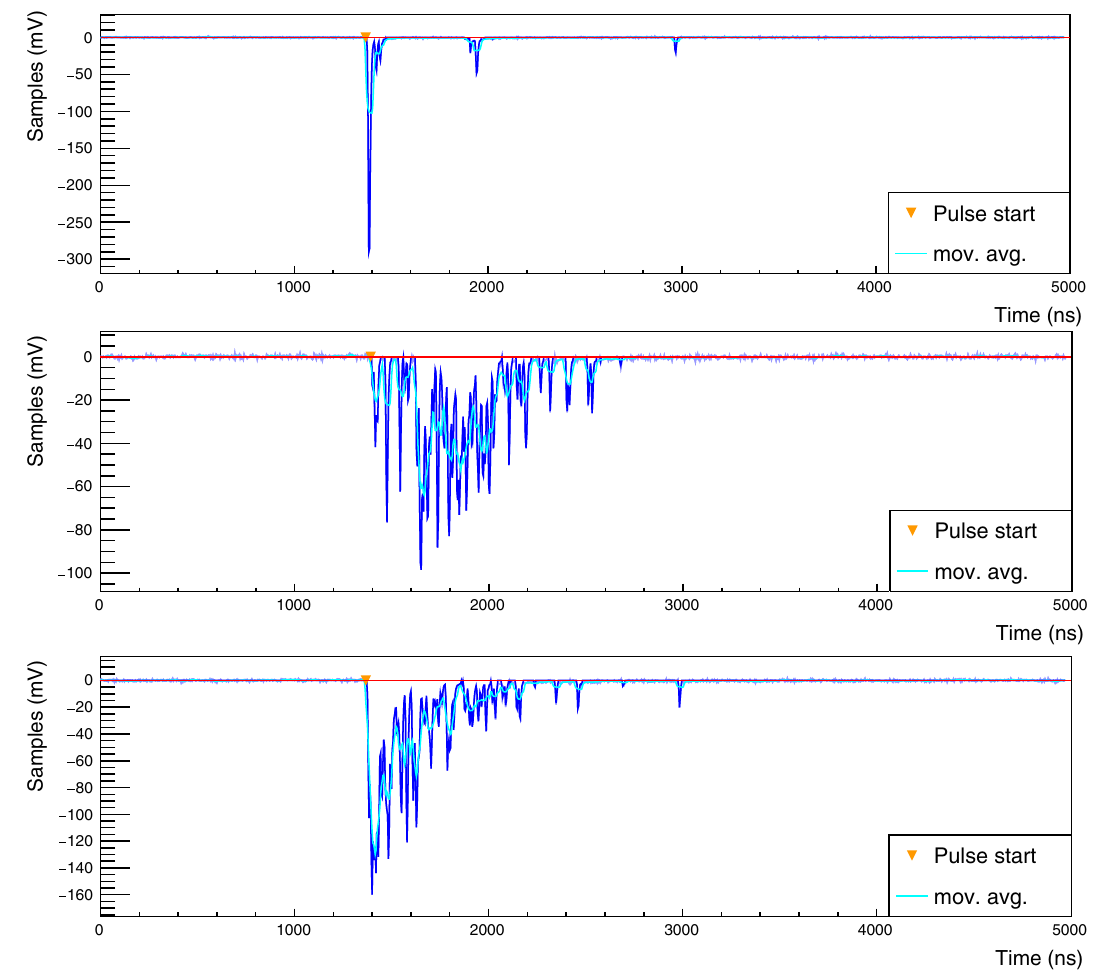
Fig. 5 Pulse shape examples: “spike-like” noise event (top); “bell-like” noise event (middle); scintillation signal (bottom)